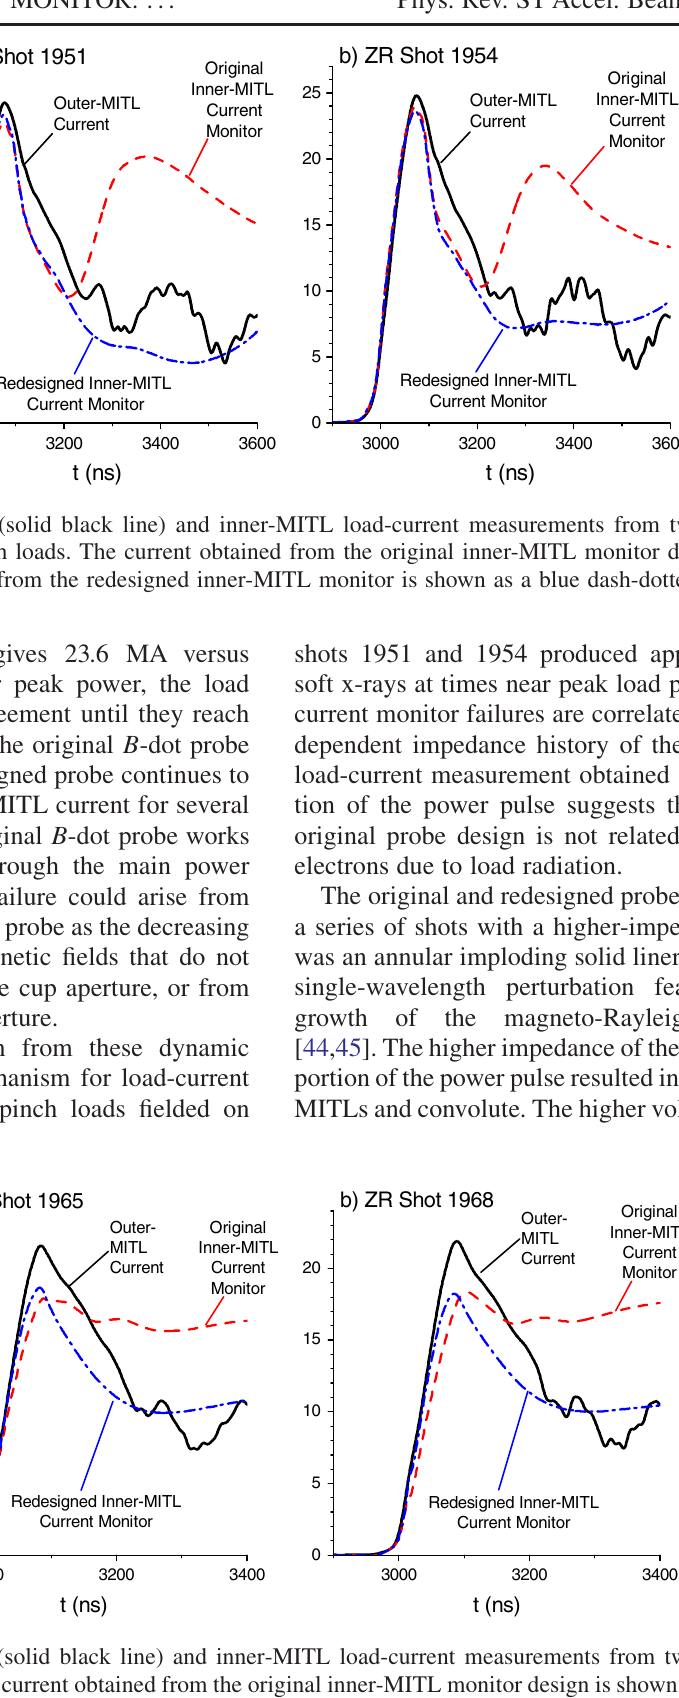
10 7 -A LOAD-CURRENT B -DOT MONITOR: . .